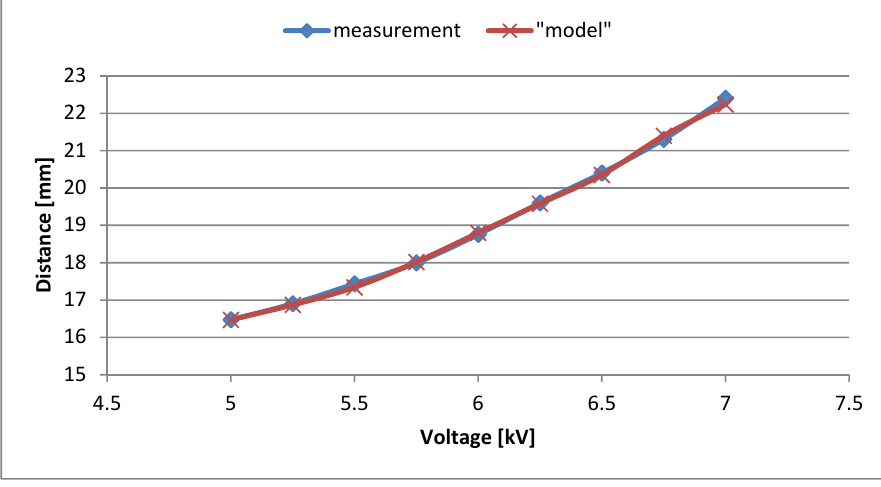
Figure 7. Comparison of membrane distances for static load force 1.42 [N].